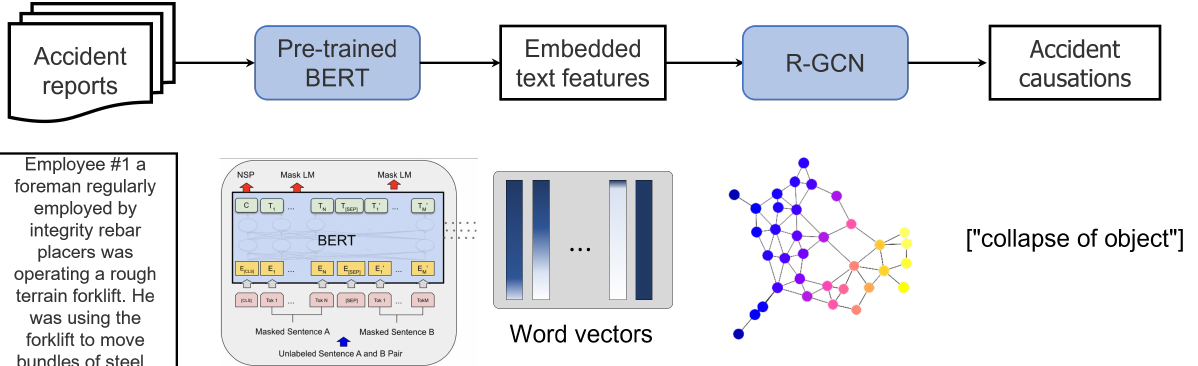
Figure 1. Overall scheme of the proposed